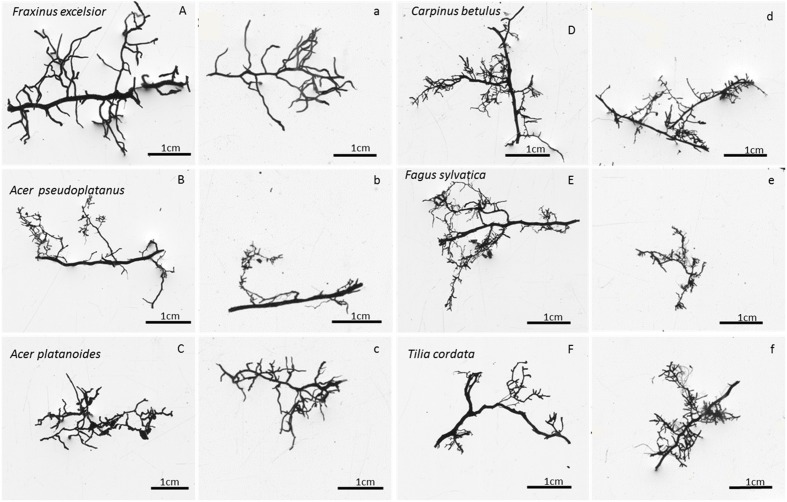
Photographs of typical terminal fine root branches of the six species (A–F) as collected in soil cores of the inventory (respective left columns, marked with capital letters) or in the ingrowth cores (respective right columns, marked with small letters). Images were taken with WinRhizo software.